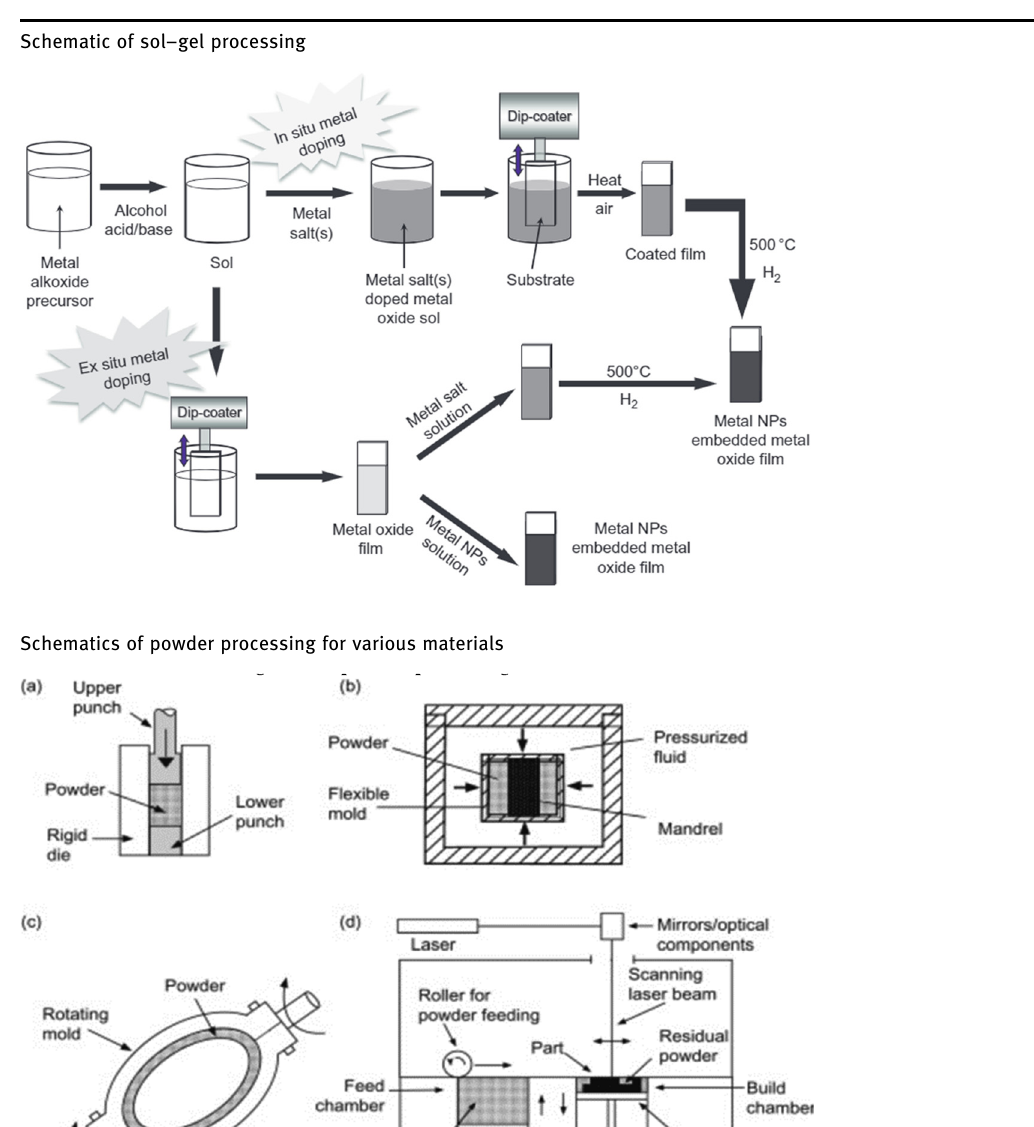
Table 5: The schematic of the synthesis methods for CMNCs. The processes, which schematics are not included, are either